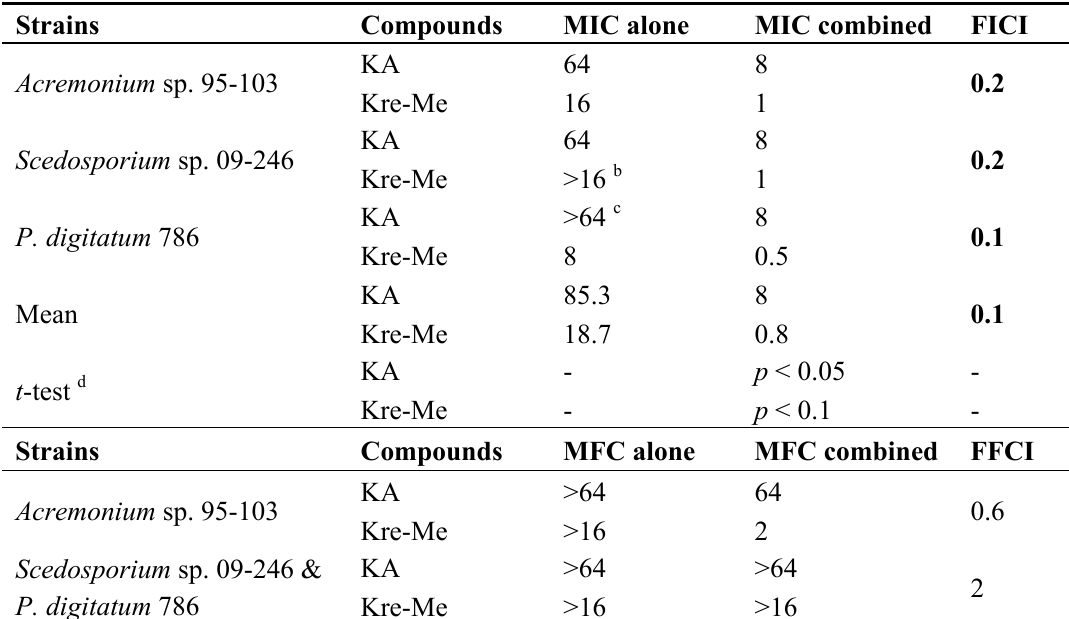
Table 4. Antifungal chemosensitization of KA (mM) to Kre-Me ( μ g/mL) tested against Acremonium , Scedosporium or P. digitatum strains: summary of CLSI-based microdilution bioassays a